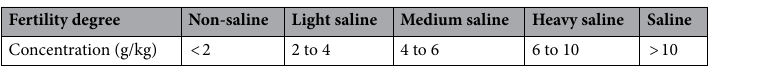
Table 7. Grading of the salinization degrees.